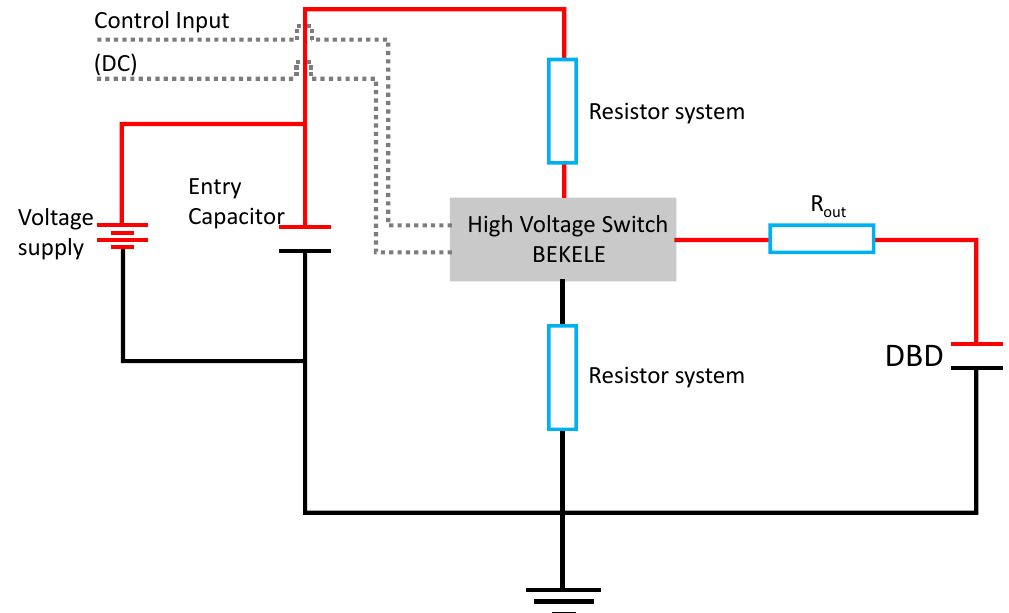
Figure 3. The ns-pulse (NS-P) power supply setup, developed in-house at EPFL by the Swiss Plasma Centre.